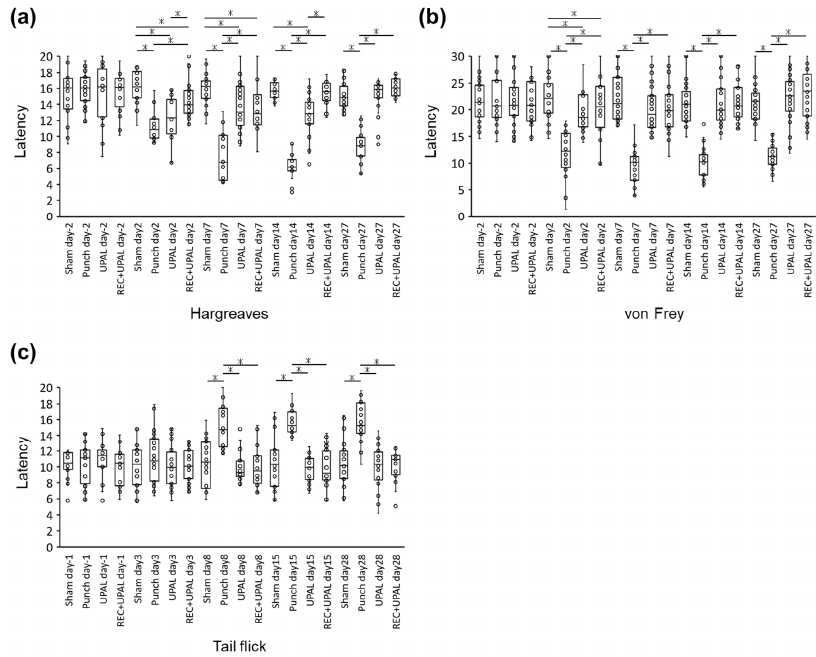
Figure 6. A mixed solution of REC and UPAL reduces nociceptive behavior. The Hargreaves and von Frey tests were performed 2 days before surgery (day -2) and on days 2, 7, 14, and 27 after surgery ( a , b ). The tail-flick test was performed 1 day before surgery (day -1) and on days 3, 8, 15, and 28 after surgery ( c ). An asterisk (*) indicates a p -value less than 0.01. The boxes represent the median and the interquartile range, while the vertical lines show the range at each time point (n = 6 rats in each group). These results suggest that the REC and UPAL mixture reduces pain caused by IVD punching and its effect is greater than the UPAL solution alone.